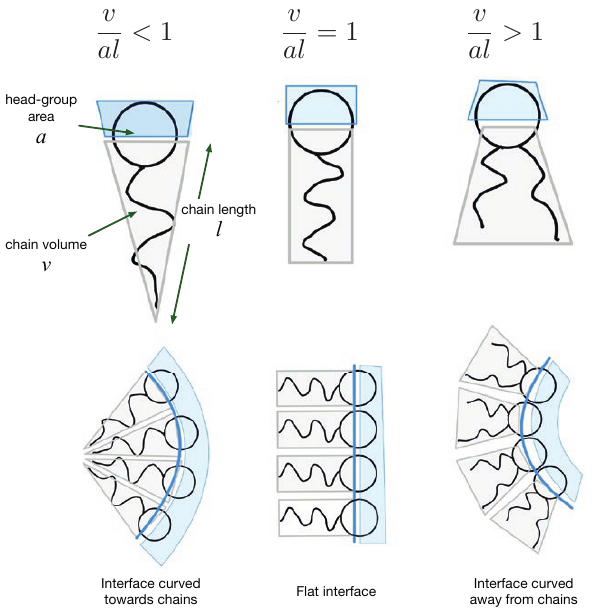
Figure 29. Schematic view of the relation between the average “wedge-shape” of a lipid or surfactant molecule (top) and the cur- vature of a monolayer of such molecules immersed in water (bot- tom).